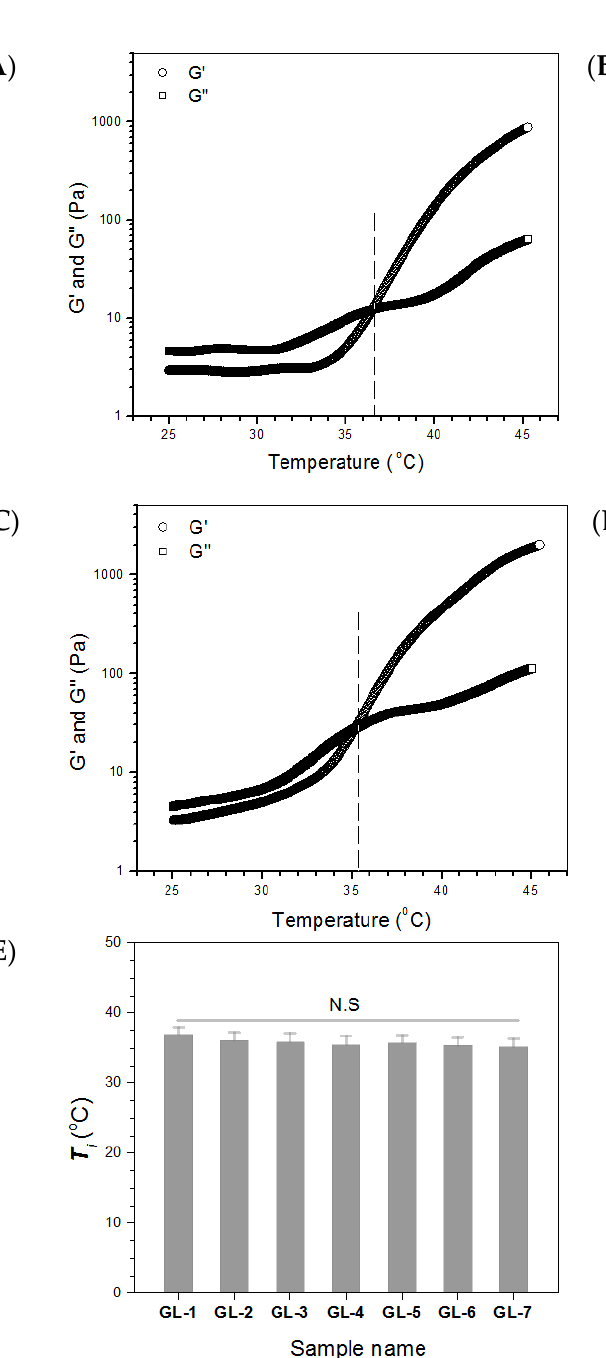
Figure 2. Representative temperature-dependence functions of G ′ and G ′′ for GL-1 ( A ), GL-3 ( B ), GL-5 ( C ) and GL-7 gels ( D ); and incipient gelation temperature (T i ) for all gels ( E ) (see Table 2 for their parameters), N.S., not significant.